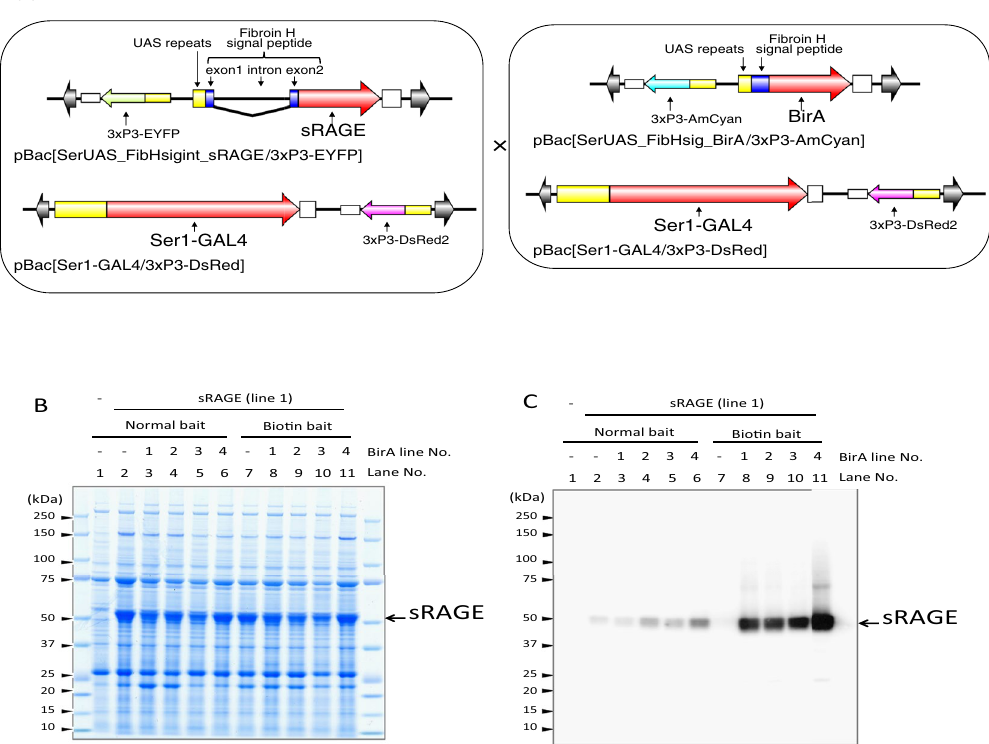
Figure 4. Effects of co-expression of the BirA gene and biotin bait on sRAGE biotinylation. ( A ) Generation of transgenic silkworms expressing both the sRAGE and BirA genes. Adult transgenic silkworms expressing the sRAGE gene or BirA gene were mated. During the fifth instar, approximately 20 μ g/g biotin bait was fed to the larvae. The MSGs were isolated from the F1 larvae, and total proteins were extracted. ( B ) CBB staining of SDS-PAGE gels. Proteins extracted from MSGs were separated by SDS-PAGE followed by staining with CBB. ( C ) Detection with streptavidin-HRP. Lysates were separated by SDS-PAGE, followed by western blotting with streptavidin-HRP. Protein extracted from MSGs of transgenic silkworms harboring only the Ser1-GAL4 construct was used as a negative control (lane 1). Numbers at the left indicate molecular masses